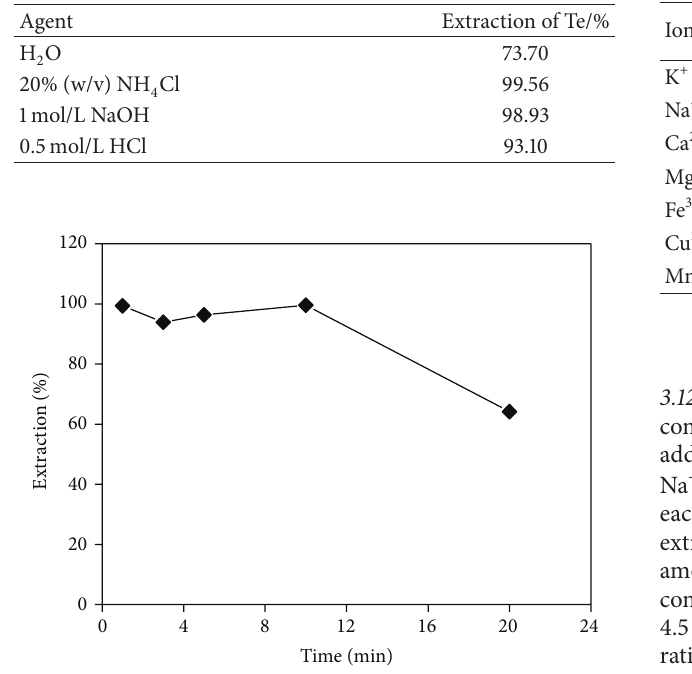
Table 7: Effect of the stripping agent on Te(IV) extraction.